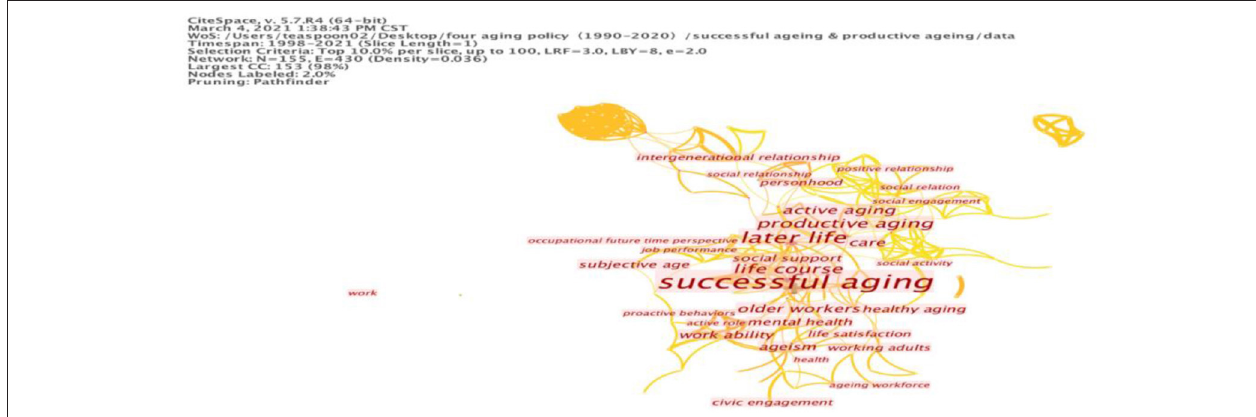
FIGURE 4 | Cluster map of keywords on successful aging and productive